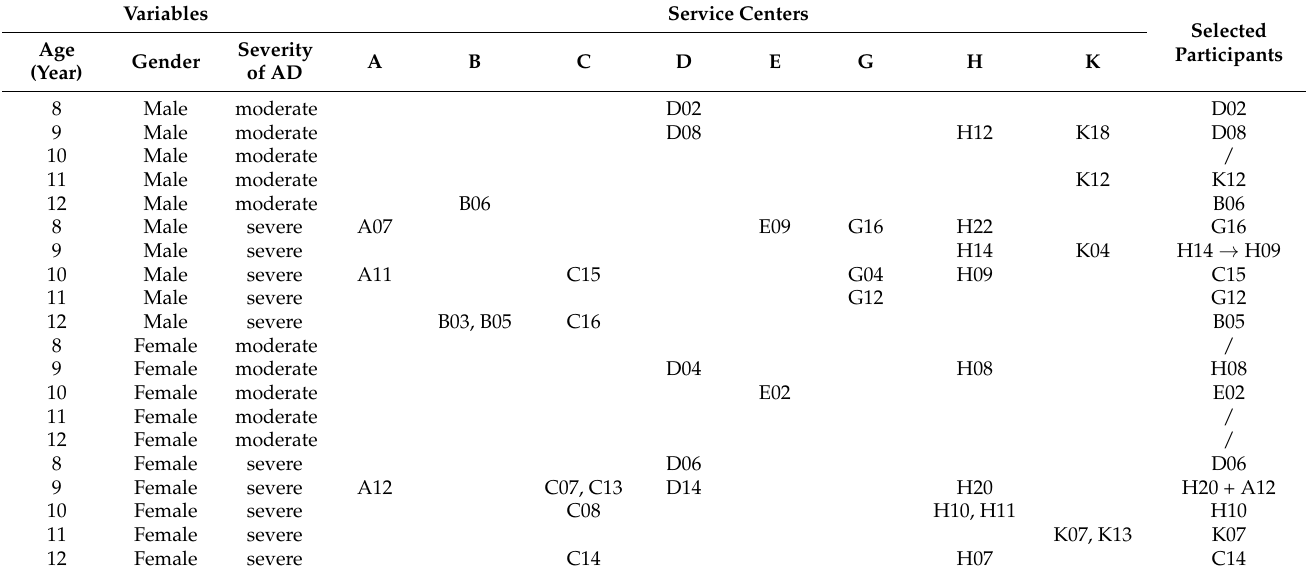
Table 1. Process of